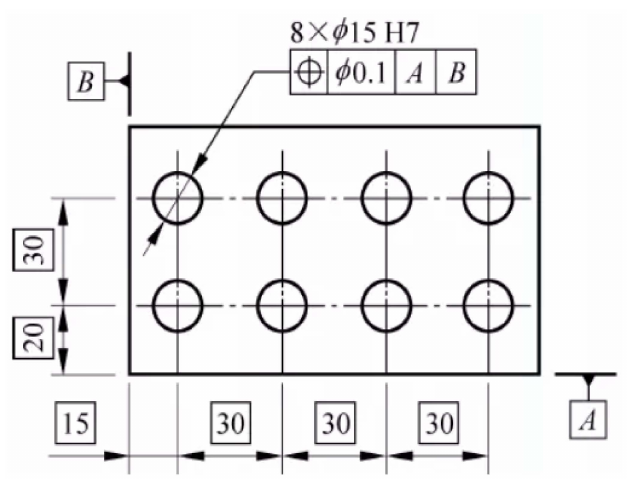
Figure 9. Example 2.